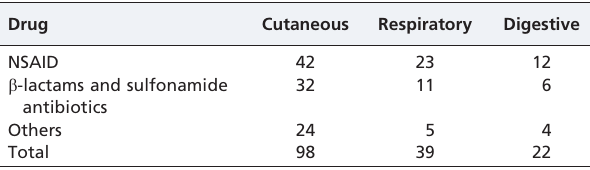
Table 1 - Type of drug and clinical manifestations.